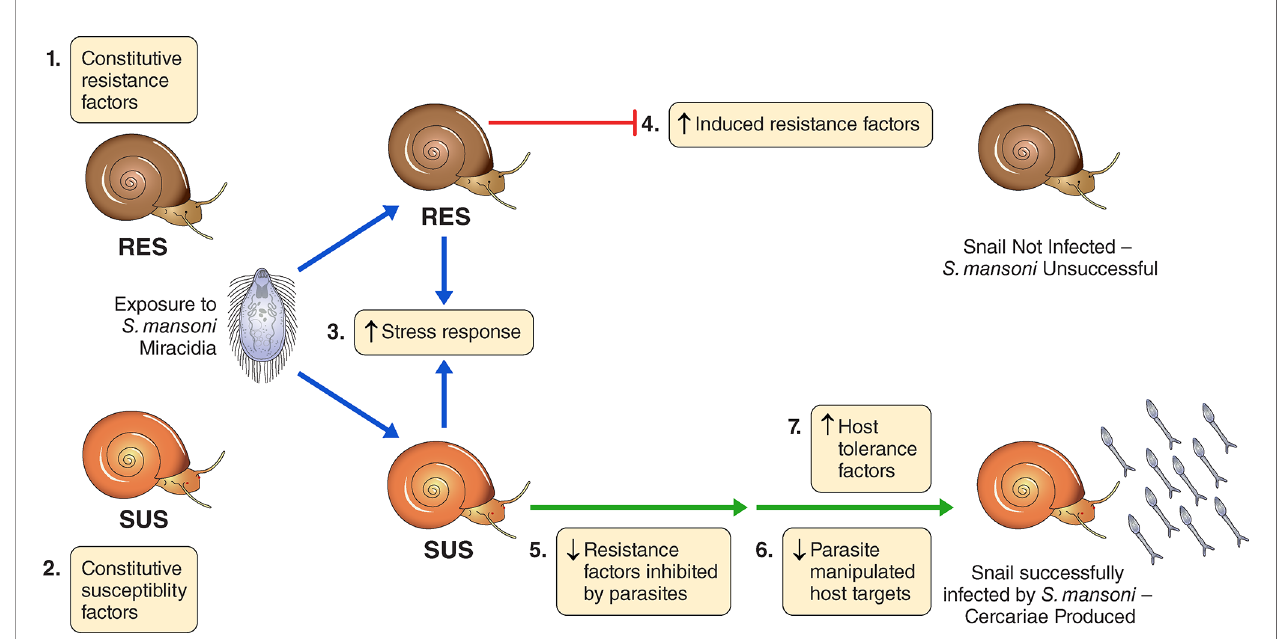
FIGURE 1 | A conceptual overview for categorizing the transcriptomics responses of B. glabrata strains susceptible (SUS) or resistant (RES) to S. mansoni , exposed or not to S. mansoni infection. We identi fi ed 7 categories: 1) Constitutive resistance factors in RES (higher expression in unexposed RES than SUS); 2) Constitutive susceptibility factors in SUS (higher expression in unexposed SUS than RES); 3) Generalized stress responses in SUS and RES (genes up-regulated in both strains shortly following exposure, 0.5 and 2 dpe); 4) Induced resistance factors in RES (up-regulated in RES only at 0.5 or 2 dpe); 5) Resistance factors inhibited by parasites in SUS (down-regulated in SUS only at 0.5 or 2 dpe); 6). Possible parasite-manipulated host targets in SUS (down-regulated in SUS only at 8 or 40 dpe); 7) Host tolerance factors in SUS (up-regulated in SUS only at 8 or 40 dpe). We emphasize membership in any of the 7 categories should be validated by